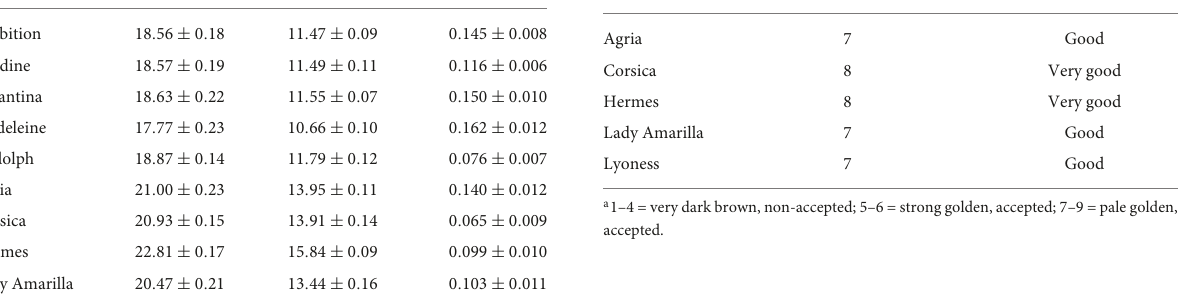
TABLE 1 DM, starch, and RS content of potato cultivars. Cultivar